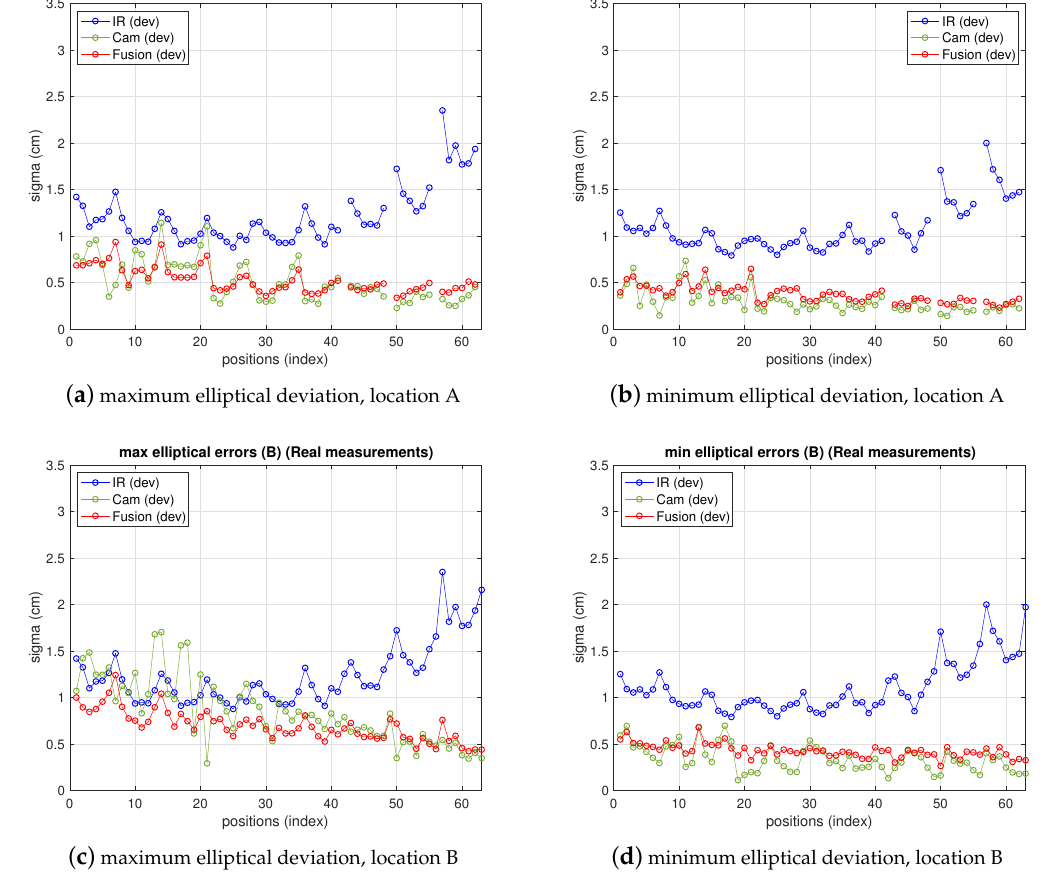
Figure 11. Elliptic deviations of IR, camera and fusion estimations from real measurements at locations A (top) and B (bottom). Left: maximum elliptical deviation; right: minimum elliptical